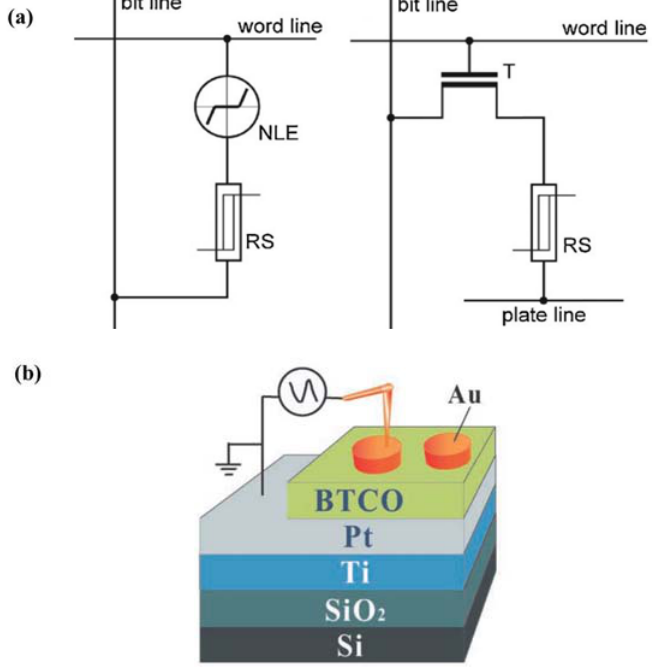
memory (RRAM): passive matrix (left), in which NLE is a serial element with a specific non-linearity, and active matrix (right) with a select transistor T (from [436]); ( b ) schematic diagram of a high performance RRAM cell with the Co-doped BaTiO 3 thin films as active layers (from